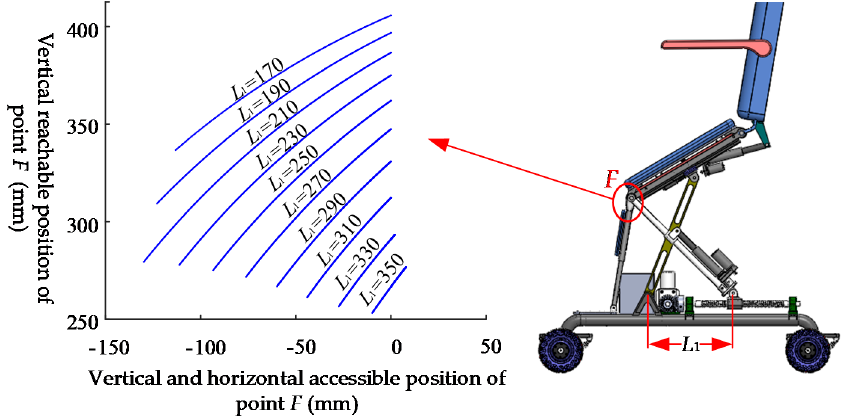
Figure 12. F -point trajectory of moving platform with different seat heights.